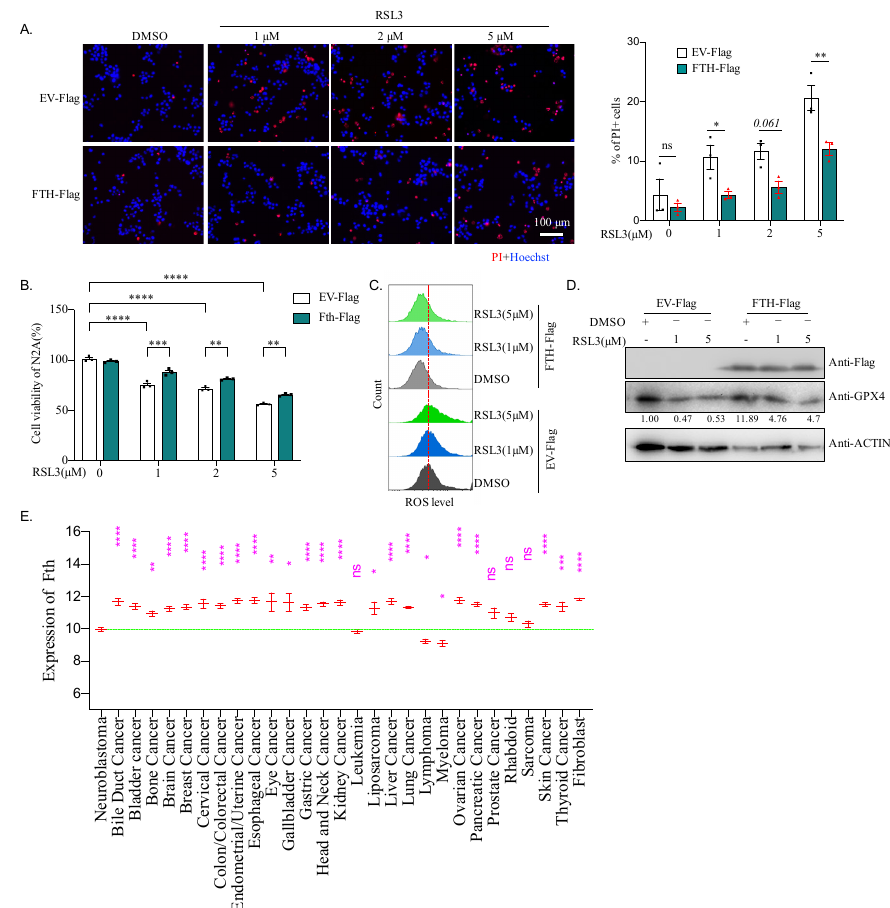
Figure 7. Overexpression of Fth rescues ferroptosis in N2A cells. ( A ) Representative images of PI/Hoechst staining of N2A cells, overexpressing pcDNA-Flag empty vector (EV-Flag) or pcDNA-Flag-FTH. The cells were treated by DMSO or 1, 2, 5 μ M RSL3 for 24 h. Ratios of PI-positive cells were quantified and showed on the right. For the concentration of 2 μ M RSL3, p = 0.061; *: p < 0.05; **: p < 0.01; ns: not significant. ( B ) Viability of N2A cells overexpress EV-Flag, or FTH-Flag was analyzed by CCK-8 assay at 24 h after treating with DMSO, or 1, 2, 5 μ M RSL3. **: p < 0.01; ***: p < 0.001; ****: p < 0.0001. ( C ) Lipid ROS level in N2A cells of overexpressing EV-Flag or FTH-Flag treated by DMSO, or 1 μ M, 5 μ M RSL3 for 24 h. ( D ) Western blotting analysis of N2A cells overexpressing EV-Flag or FTH-Flag treated by DMSO, or 1 μ M, 5 μ M RSL3 for 24 h. Quantified relative expression of GPX4 to β -actin by Image J. ( E ) Relative expression of Fth in neuroblastoma and other 28 cancers. Data were extracted from the CCLE database (https://sites.broadinstitute.org/ccle/) (Accessed on 3 August 2021), a public, open access repository. *: p < 0.05; **: p < 0.01; ***: p < 0.001; ****: p < 0.0001; ns: not significant .